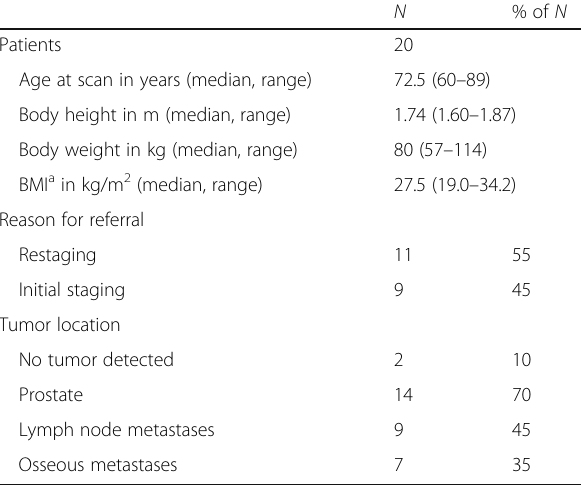
Table 3 Summary of patient characteristics